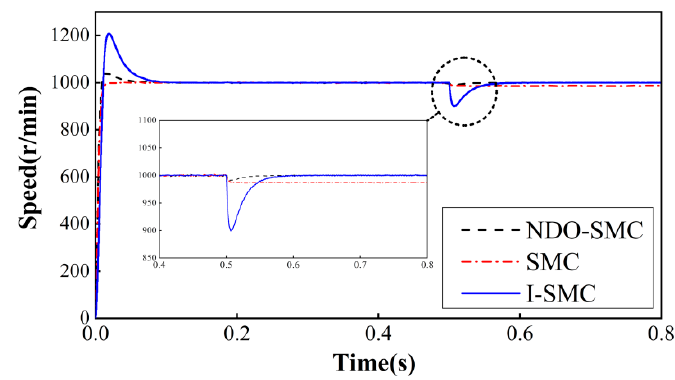
Figure 3. Speed response waveform of three controllers.